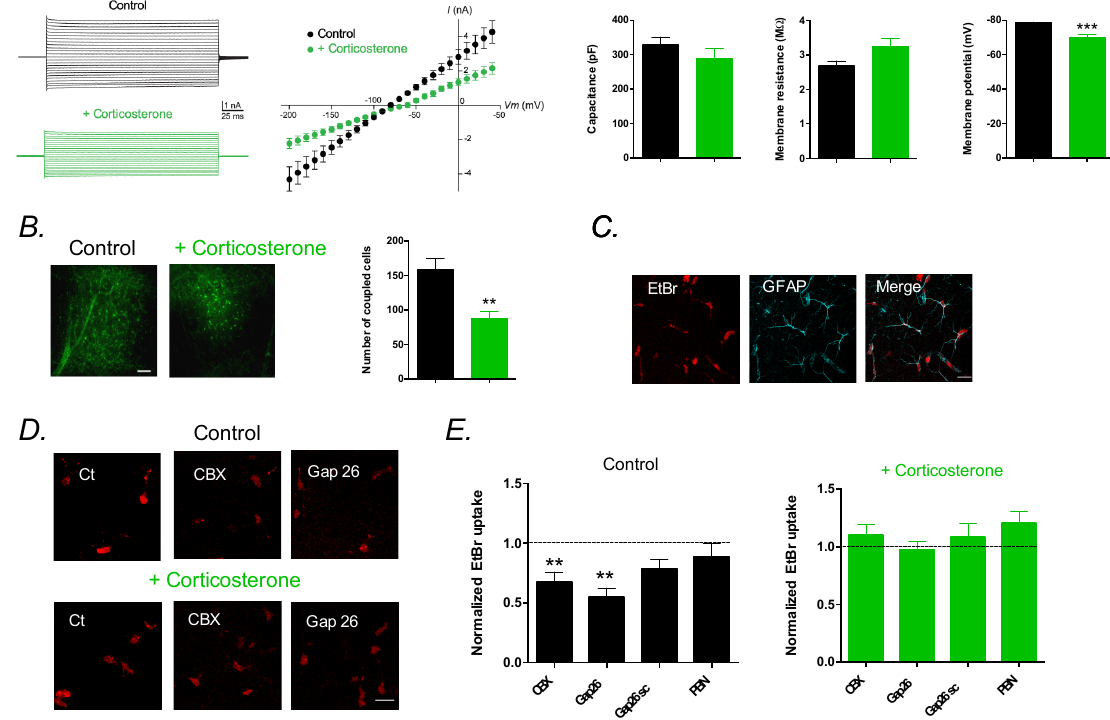
Figure 1. Chronic corticosterone treatment alters astrocytes’ membrane properties and astroglial connexin functions in the hippocampus. ( A ) Electrical properties of astrocytes with representative current–voltage (I–V) plots. Data are mean ± SEM of I–V curves, capacitance, membrane resistance and intrinsic membrane properties of astrocytes from control VEH mice ( n = 7 cells from 5 mice) and corticosterone (CORT)-exposed mice ( n = 8 cells from 5 mice). ( B ) Representative images and quantification of GJ-mediated biocytin coupling in CA1 stratum radiatum astrocytes from nontreated mice ( n = 9 cells from 5 mice) and corticosterone-treated mice ( n = 10 cells from 5 mice). Scale bar, 100 µm. Data are mean ± SEM of number of coupled cells. ** p < 0.01, and *** p < 0.001: significantly different from control VEH mice. ( C ) Representative basal EtBr uptake (red) in stratum radiatum astrocytes labeled with GFAP (cyan) in hippocampal slices. Scale bar, 20 µm. ( D ) Higher magnification of astroglial EtBr uptake (red) in hippocampal slices from control mice and mice treated with corticosterone, in basal conditions (Ct) and in the presence of CBX (200 µ M), or Gap26 (100 µ M), applied 15 min prior and during EtBr uptake assay. Scale bar, 20 µm. ( E ) Astrocytic EtBr uptake normalized to control conditions in slices from untreated mice (Control) incubated with CBX (200 µ M, n = 13 slices from 5 mice), Gap26 (100 µ M, n = 12 slices from 5 mice), Gap26 scramble peptide (Gap26 scr, 100 µ M, n = 13 slices from 5 mice) or Probenecid (PBN, 1 mM, n = 8 slices from 3 mice) and from mice treated with corticosterone incubated with CBX (200 µ M, n = 11 slices from 5 mice, Gap26 (100 µ M, n = 13 slices from 5 mice, Gap26 scramble peptide (Gap26 scr, 100 µ M, n = 12 slices from 5 mice, or Probenecid (PBN, 1 mM, n = 8 slices from 3 mice). Asterisks indicate statistical significance on raw data. ** p < 0.01: significantly different from the basal condition (no treatment) in control